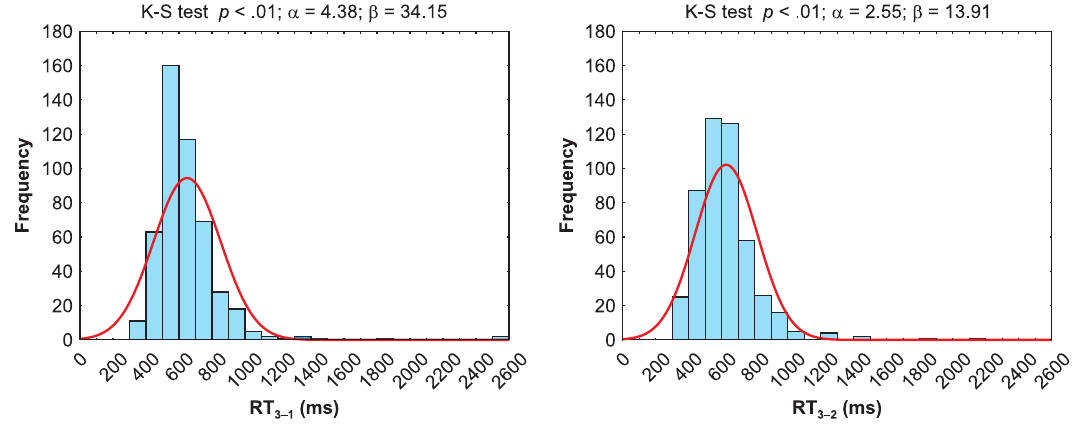
, RT = reaction 1–1 1–2